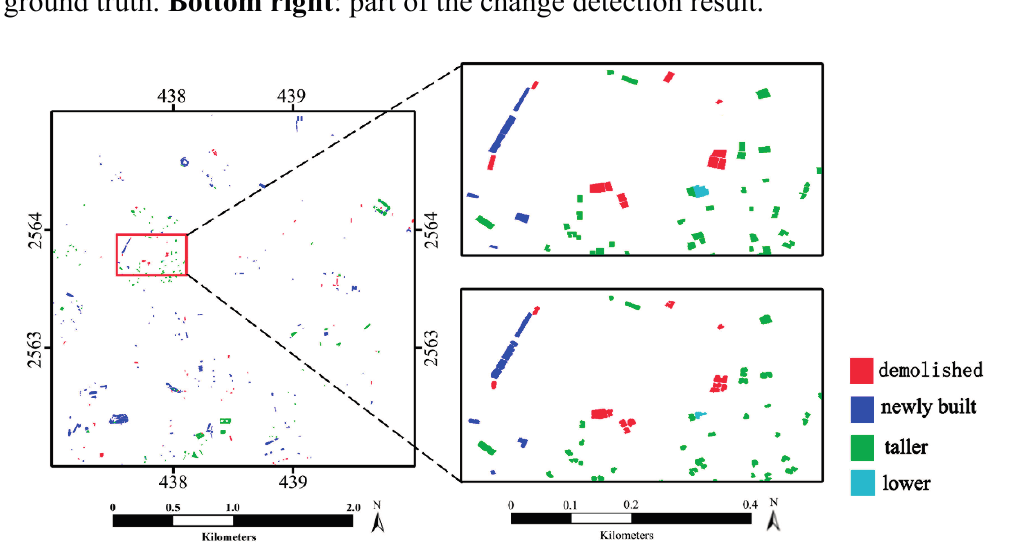
Figure 5. Change detection results of the proposed method, part of the change detection result, and corresponding ground truth. Left : change detection results. Top right : details of the ground truth. Bottom right : part of the change detection